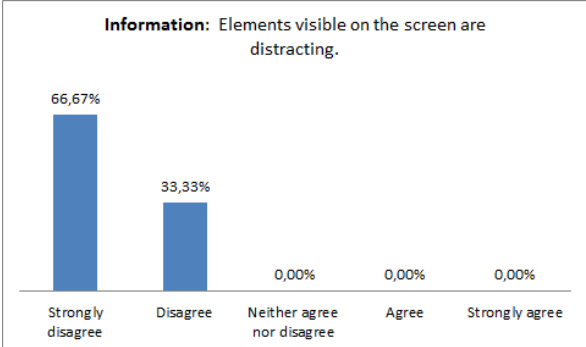
Figure 15: Distracting information.